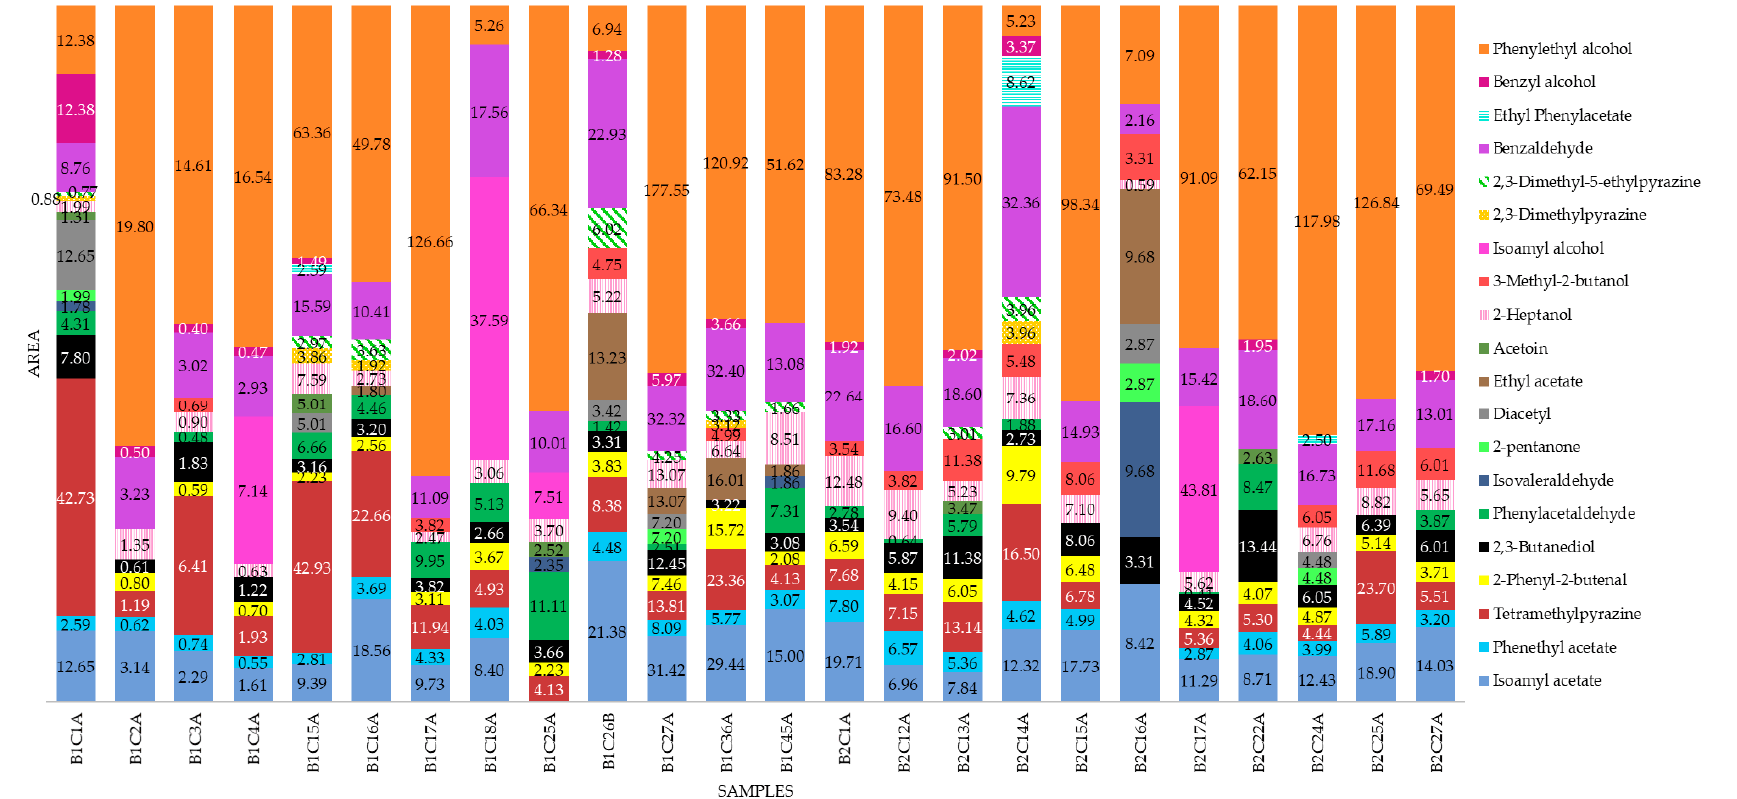
Figure 5. Peak areas of the volatile compounds found in the fermented cocoa bean samples. All values are reported in scientific notation 10 3 . Sample codes: B1 = Block 1, B2 = Block 2, C# = number of the tree, and A or B = position of tree (row).